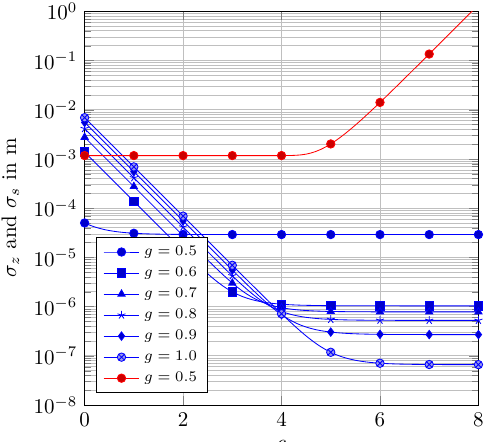
Figure 17. Measurement uncertainty of surface height σ z for a screen showing an optimal pattern with fringe frequency k scr low- to high-gloss surfaces c and a focus on surface g = 0 . 5m to a focus on screen g = 1 . 0m in comparison with the plenoptic mea- surement uncertainty σ s